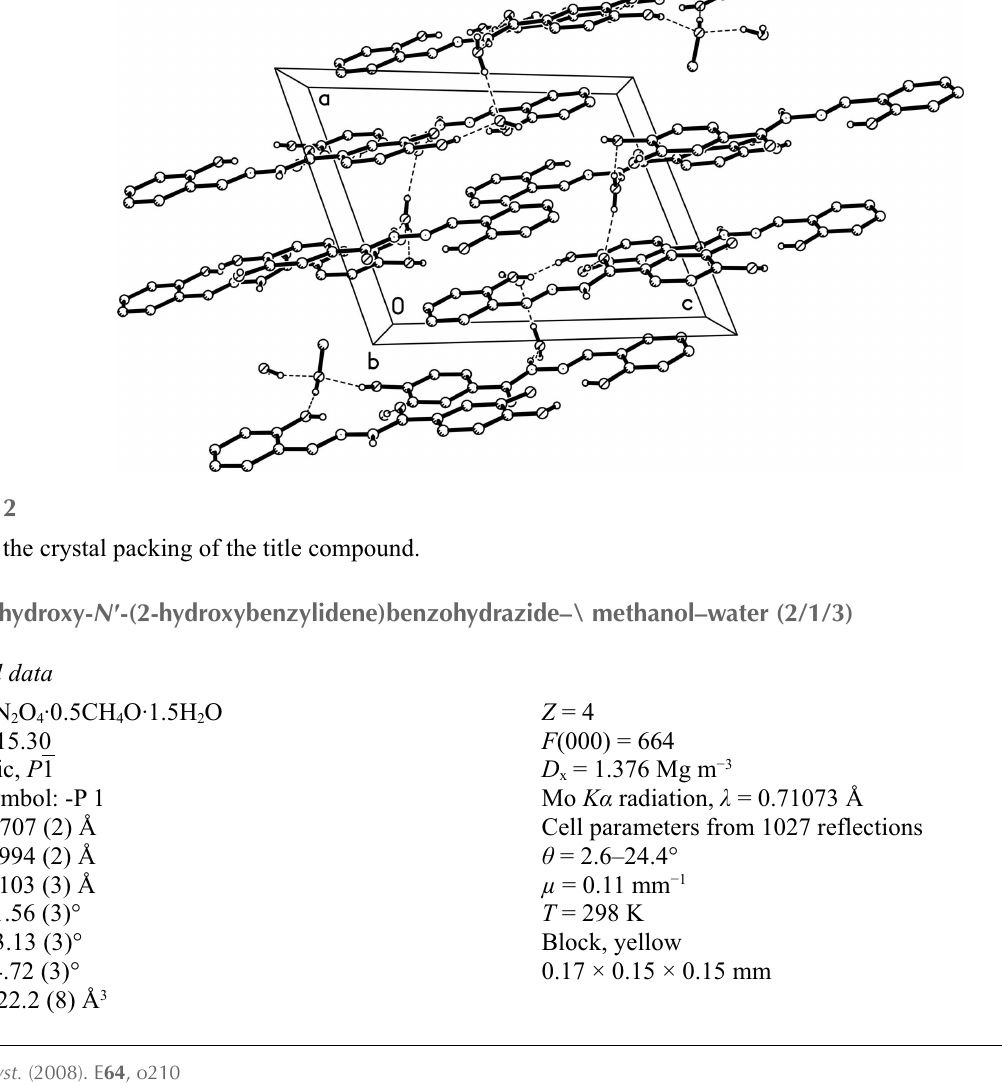
sup-2 Acta Cryst. (2008). E 64 , o210